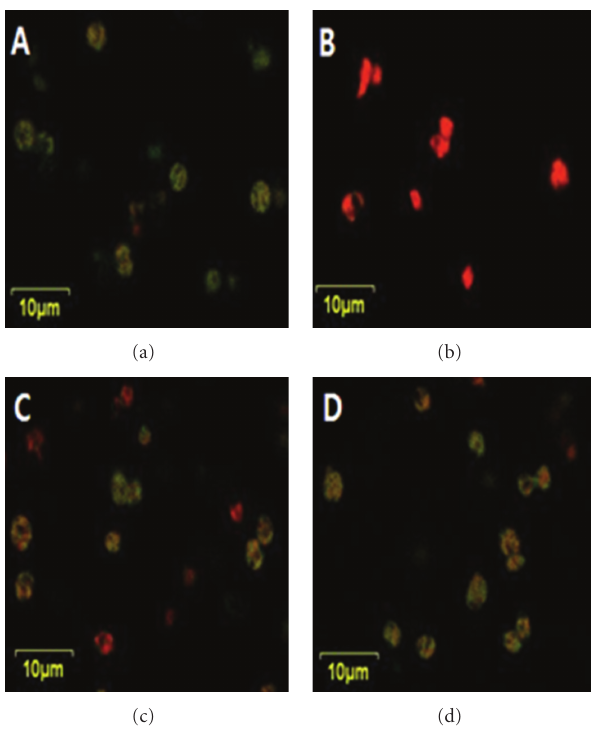
Figure 6: Comparison of confocal laser micrograph of Scenedesmus sp. stained with Nile red showing residual cellular lipid droplets; (a) control (only solvent extraction without any pretreatment), (b) solvent extraction with homogenization pretreatment, (c) solvent extraction with microwave pretreatment, and (d) solvent extraction with ultrasonification pretreatment.